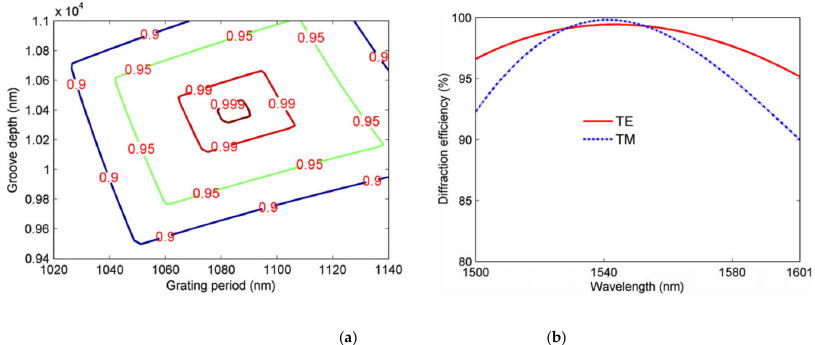
Figure 31. ( a ) Contour of the minimum − 1st order di ff raction e ffi ciencies between TE and TM po ‐ larizations versus groove depth and grating period. ( b ) Plot of the − 1st order di ff raction e ffi ciencies versus incident wavelength, with grating period Λ = 1080 nm, h = 10,300 nm, and θ i = 45.85° (Littrow angle for 1550 nm incident wavelength). In 2011, C. Zhou, T. Seki, et al. [56] in Japan developed and manufactured a 170 × 40× 1 mm 3 high ‐ efficiency fused ‐ silica transmission grating with a line density of 1250 lines/mm for terawatt ‐ scale Ti–sapphire lasers. The incidence angle was 30°, and the back ‐ side was anti ‐ reflection (AR) ‐ coated. Figure 32 depicts the as ‐ fabricated grating morphol ‐ ogy. The diffraction efficiency of the transmission grating in the 750–850 nm band was greater than 90%. The relationship between the duty cycle, groove depth, and diffraction efficiency is shown in Figure 33. Under TE polarization, the incidence angle was 30°, the wavelength band was approximately 800 nm, the duty cycle was 0.49, and the depth was 1380 nm; the diffraction efficiency of the transmission grating reached up to 98%.